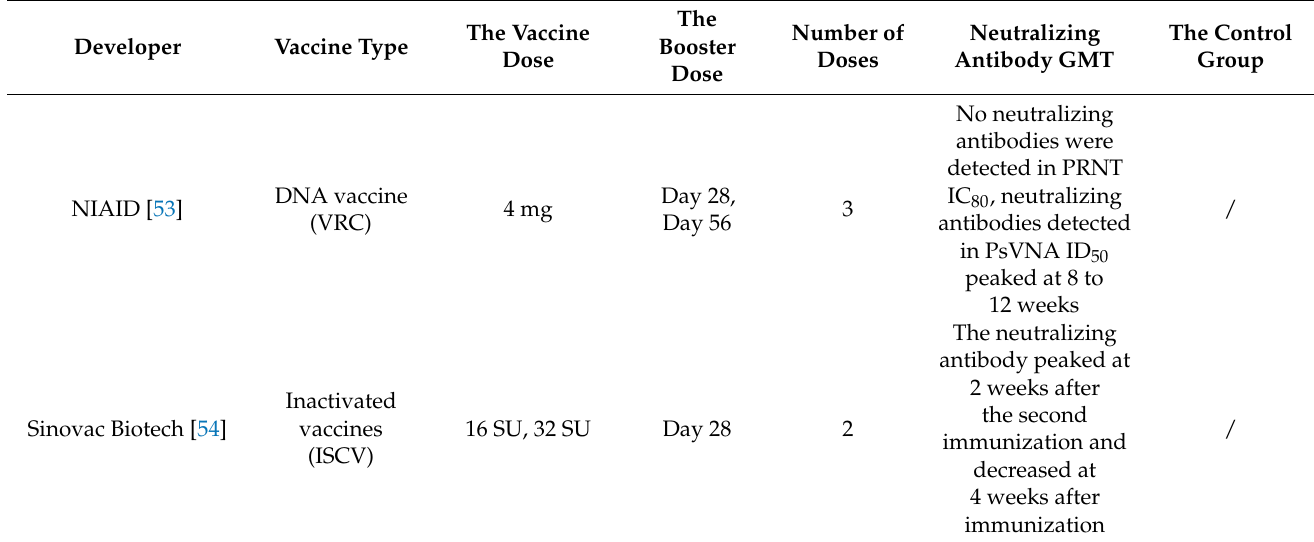
Table 3. Clinical trial results of SARS-CoV candidate